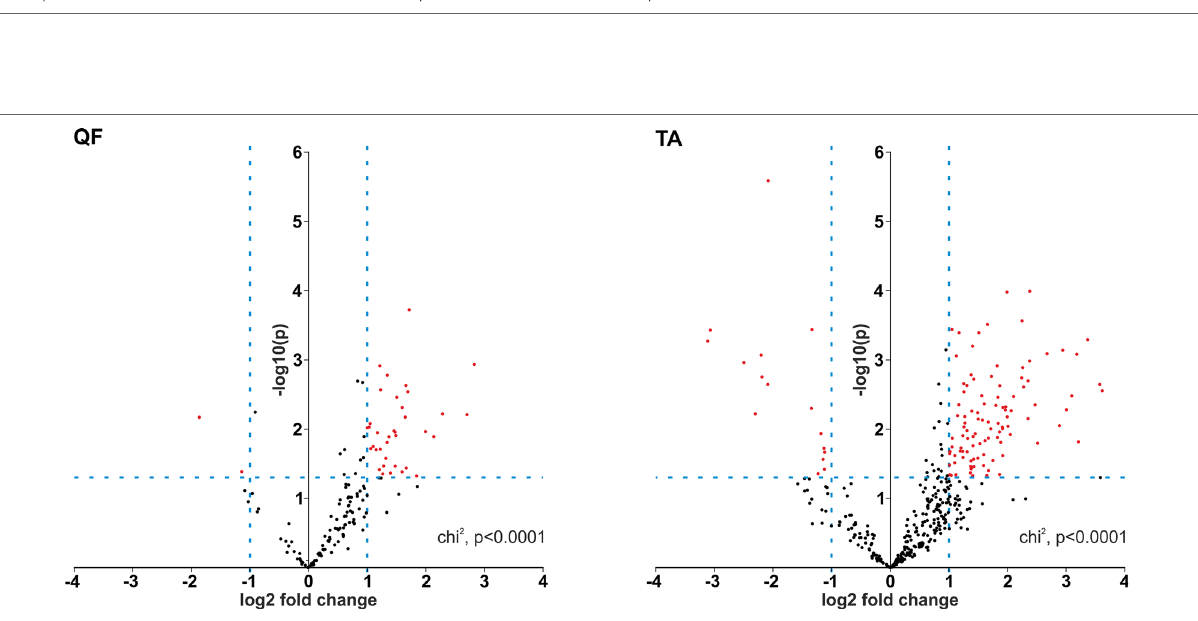
FIGURE 4 | Prevalence of circRNAs with increased levels in DM1. Volcano plots depicting differences in the levels of “common” circRNAs (dots) in DM1 and control samples in QF (left-hand side) and TA (right-hand side). Positive and negative values of log2 fold change indicate increased and decreased circRNAs in DM1. Each red dot represents circRNA fulfilling the following criteria of expression change: p -value <0.05 and log2 fold change ≤−1 or ≥1 (the thresholds indicated by dotted